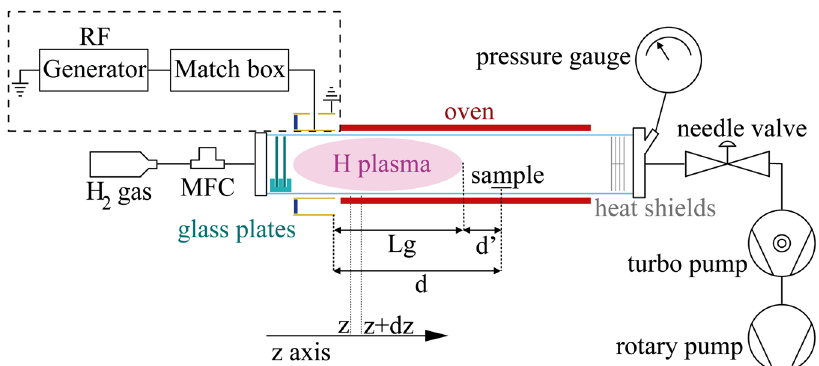
Fig. 5 Set-up of the plasma furnace. The quartz tube has a length of ca. 1 m and a diameter of 80 mm (drawing not to